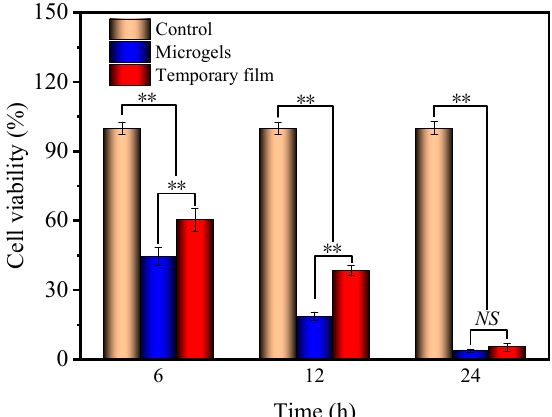
Figure 8. Evaluation of cytotoxic effects (antitumor activities) of PCD film (control), microgels, and temporary film on Hela cells at the culture times of 6, 12, and 24 h. Significance was defined as ** p < 0.01, n = 5.